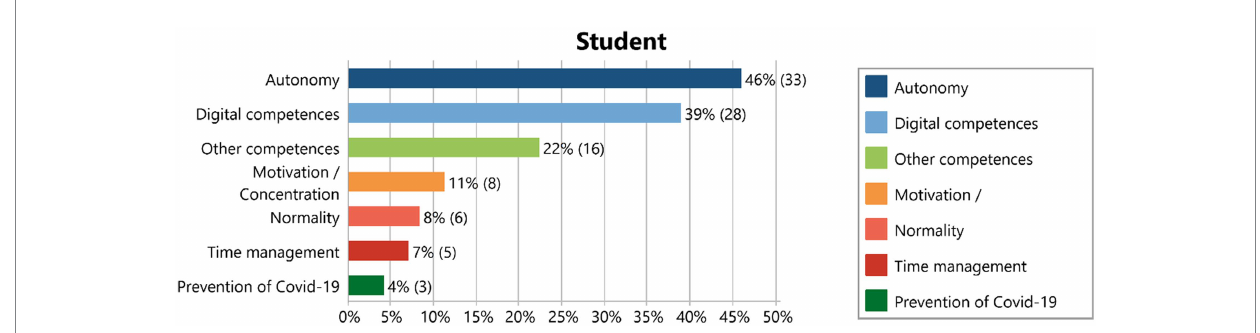
FIGURE 9 Frequency of documents referring to the subcategory Student, within the category Potential and